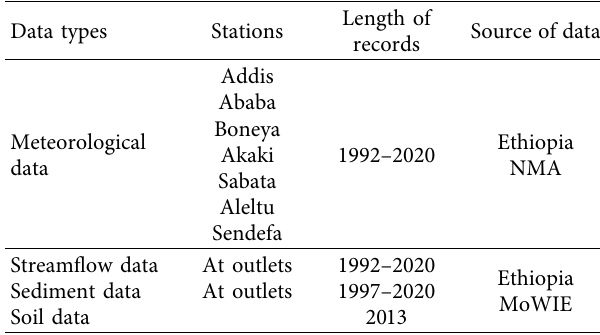
Table 1: Data sources and types.